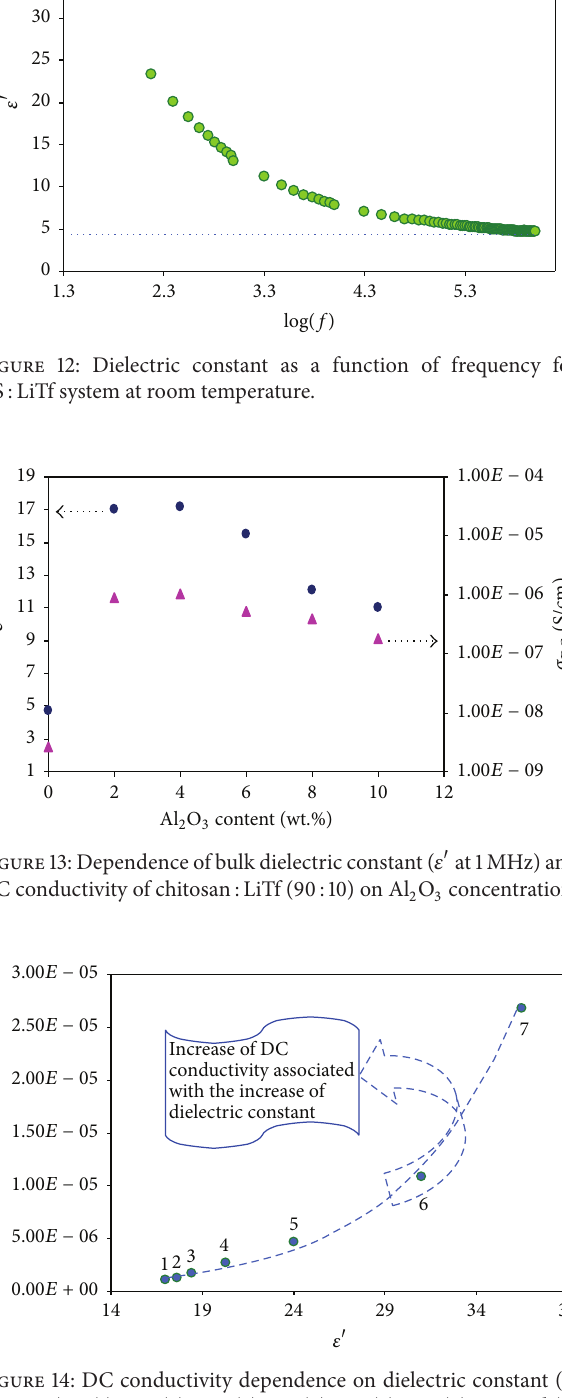
Figure 14: DC conductivity dependence on dielectric constant ( 𝜀 󸀠 at 1MHz) at (1) 303, (2) 308, (3) 313, (4) 318, (5) 323, (6) 328, and (7) 333 K for CSNC2 system.